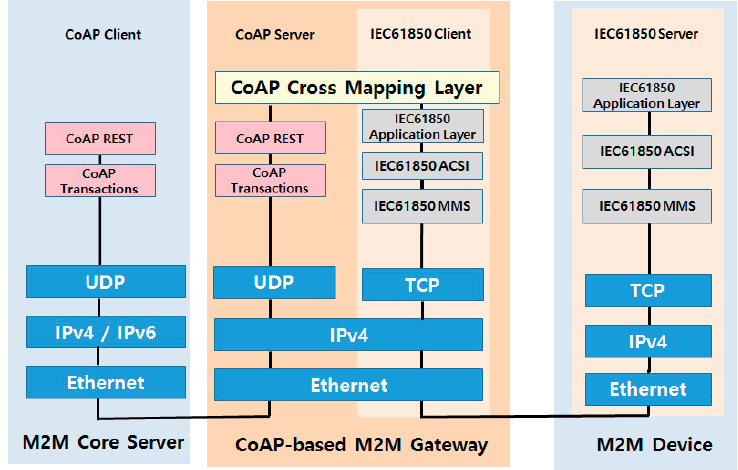
Figure 5. Protocol structure for application layer mapping between the IEC 61850 and CoAP.